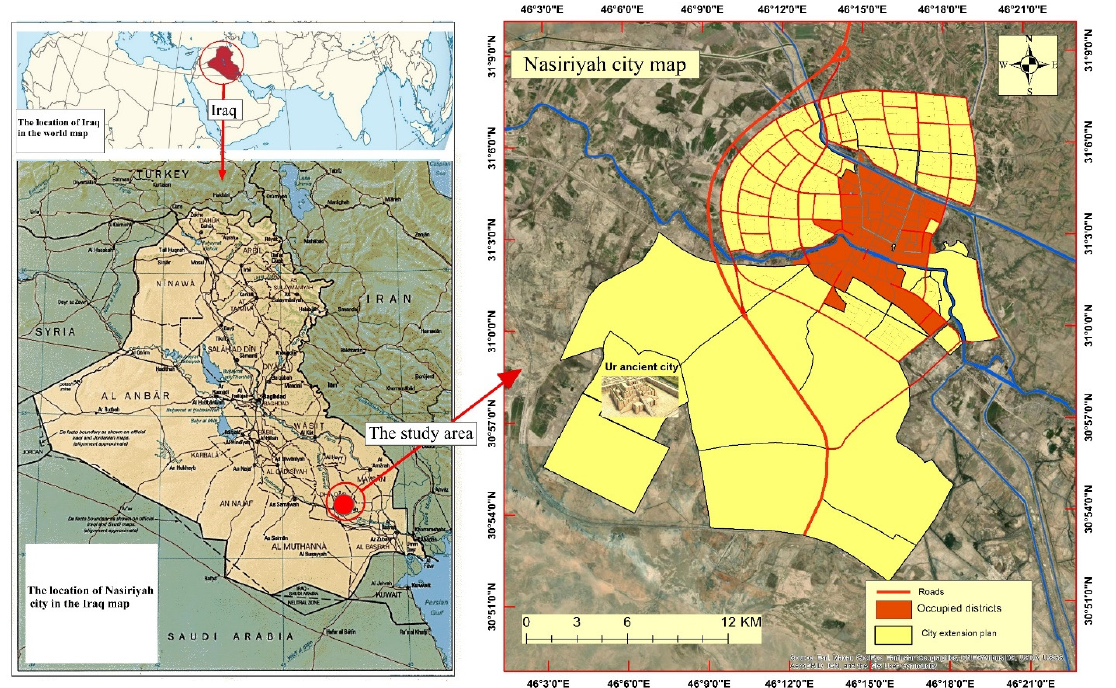
Figure 1. Location of Nasiriyah City. Upper left: location of Iraq on the world map. Bottom left: location of Nasiriyah City on the Iraq map. Right: map of Nasiriyah City showing the location of the ancient city of Ur (4000 BC). The brown area comprises 92 occupied